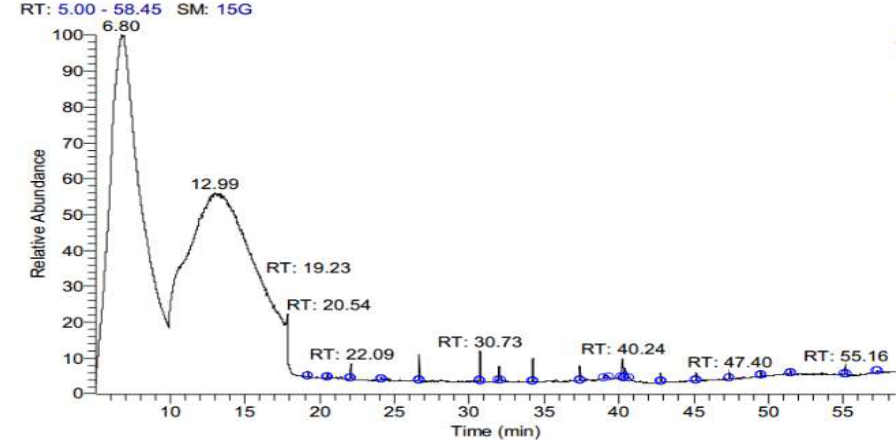
Figure 2. GC-MS Chromatogram of S. costus extract by SFE at a pressure of 20 MPa (20).